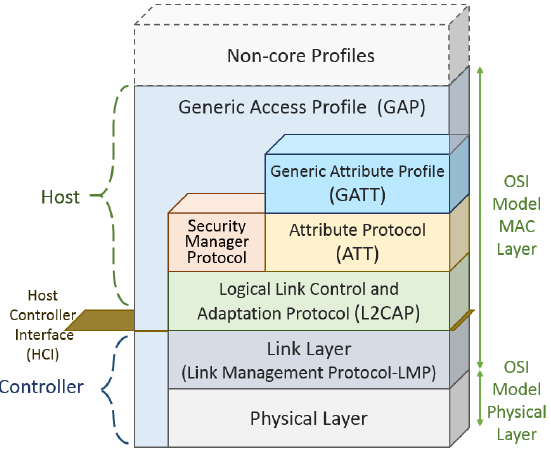
Figure 7. Bluetooth low energy protocol